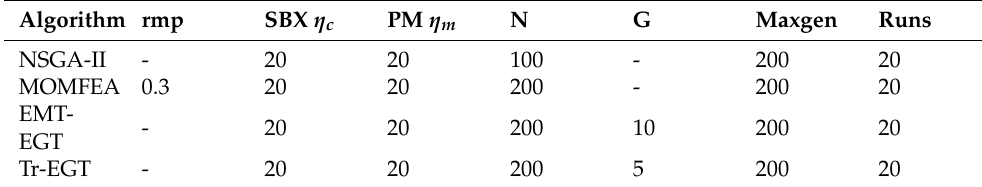
Table 5. Parameter setting for the multitasking multiobjective experiment. Algorithm